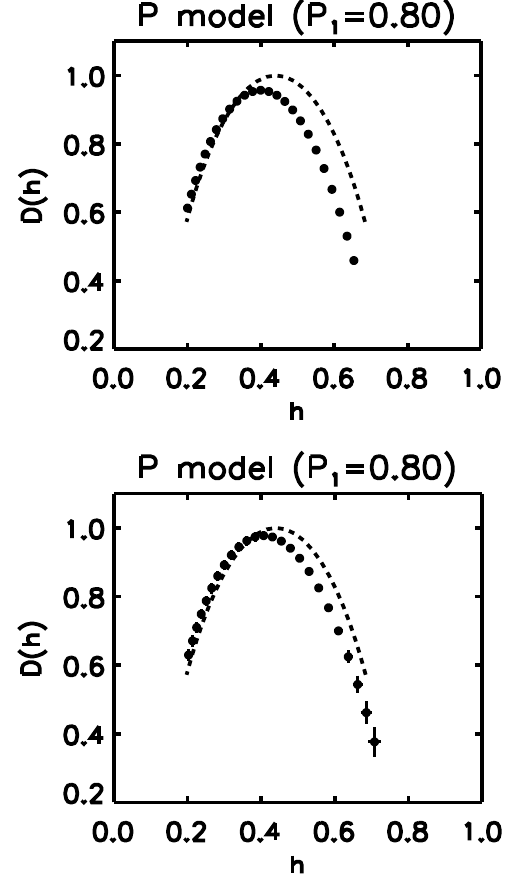
Fig. 6. Singularity spectra of the p -model calculated directly from the wavelet transform modulus maxima (upper) and by the Legen- dre transform (lower). Errors were calculated and are shown only for the Legendre transform method. Dashed curves represent the theoretical singularity